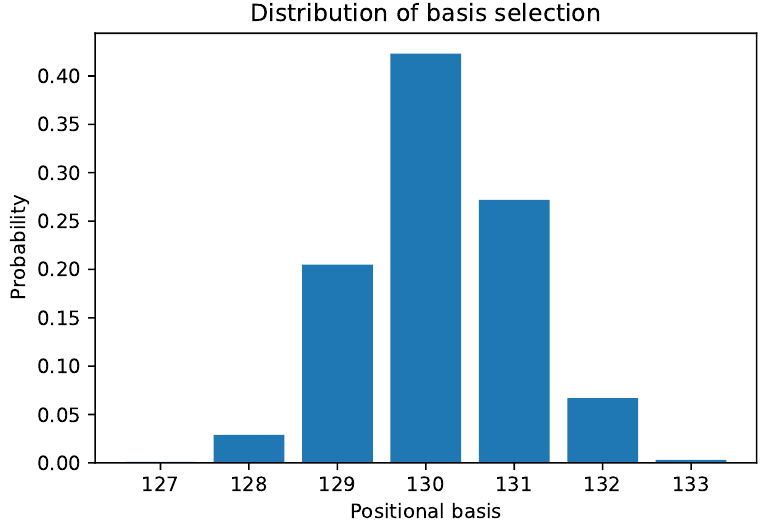
Figure 6. Possible PPCA bases with associated